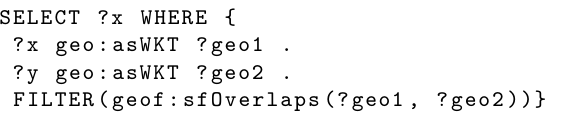
Figure 4. Example of a spatial quantitative